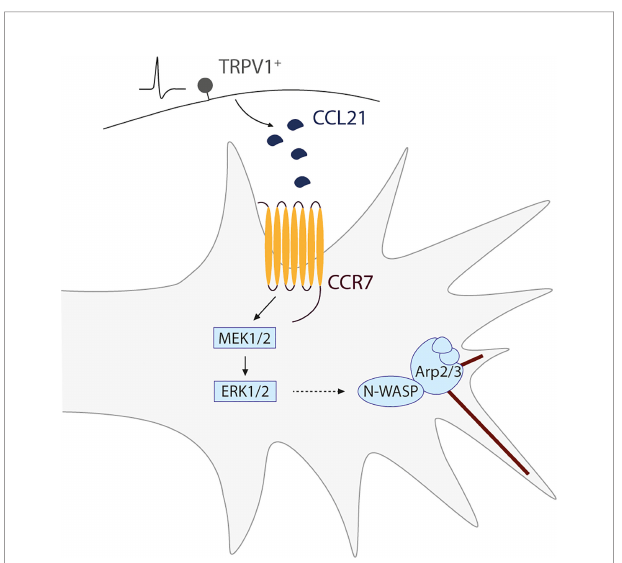
FIGURE 6 | Schematic representation of the proposed mechanism for a novel nociceptor-proprioceptor dialogue leading to neuritic growth. Activated TRPV1 + nociceptors secrete CCL21 which promotes actin branching in the growth cone of proprioceptor neurons. This mechanism is mediated by the CCL21-CCR7 interaction, leading to a downstream activation of the MEK- ERK pathway and fi nal N-WASP-related actin cytoskeleton modi fi